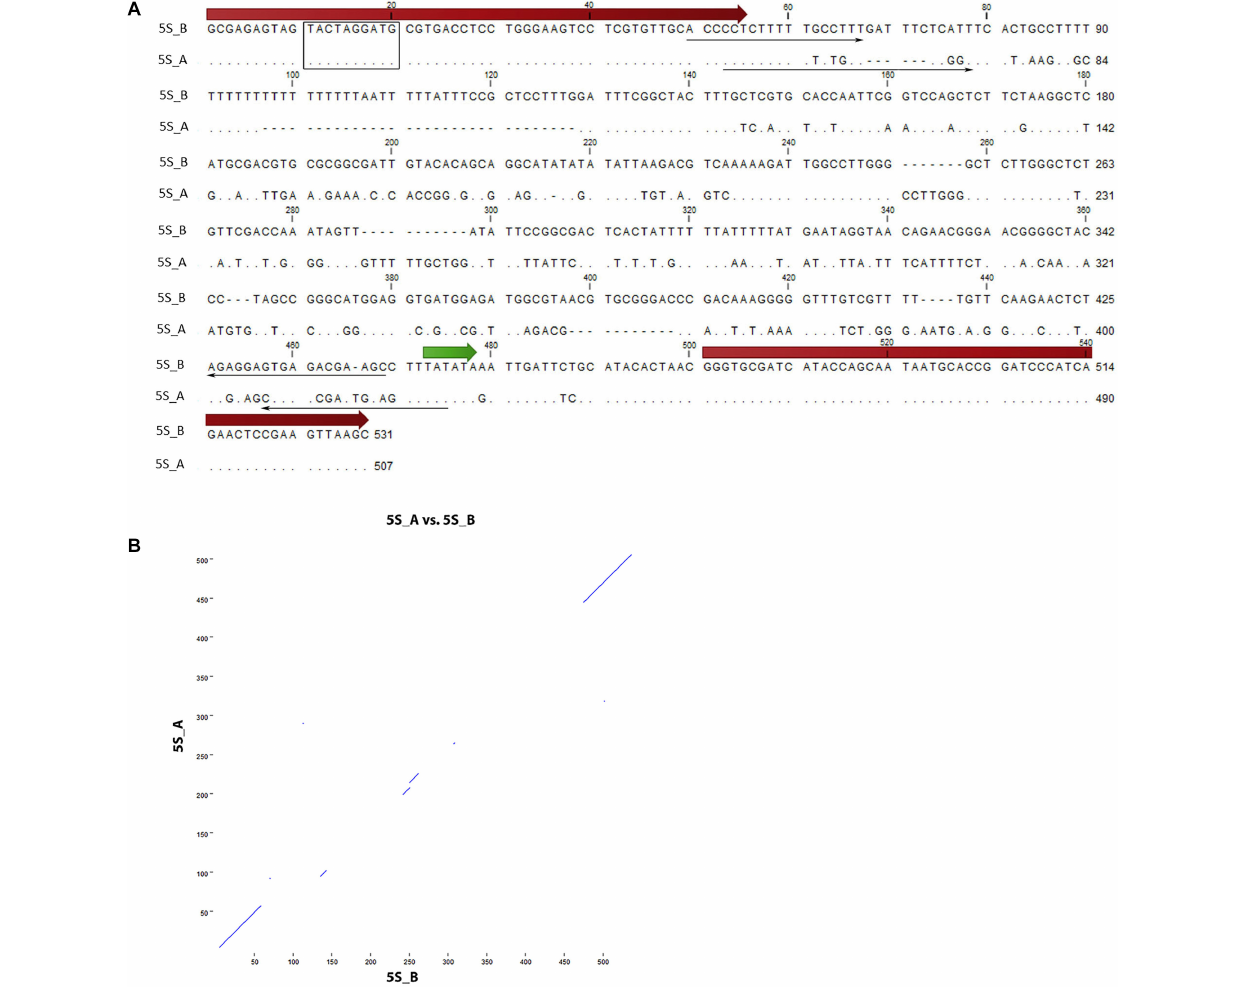
FIGURE 1 | Sequence analysis of 5S rDNA clones from Rosa canina . (A) Alignment of the 5S_A and 5S_B clones. The position of 5S rRNA coding regions (thick arrows), primers (thin arrows), and regulatory regions (TATA box—in green, Box-C—rectangle) are highlighted. (B) Dot plot of pairwise comparisons clones. Note that only coding regions showed significant